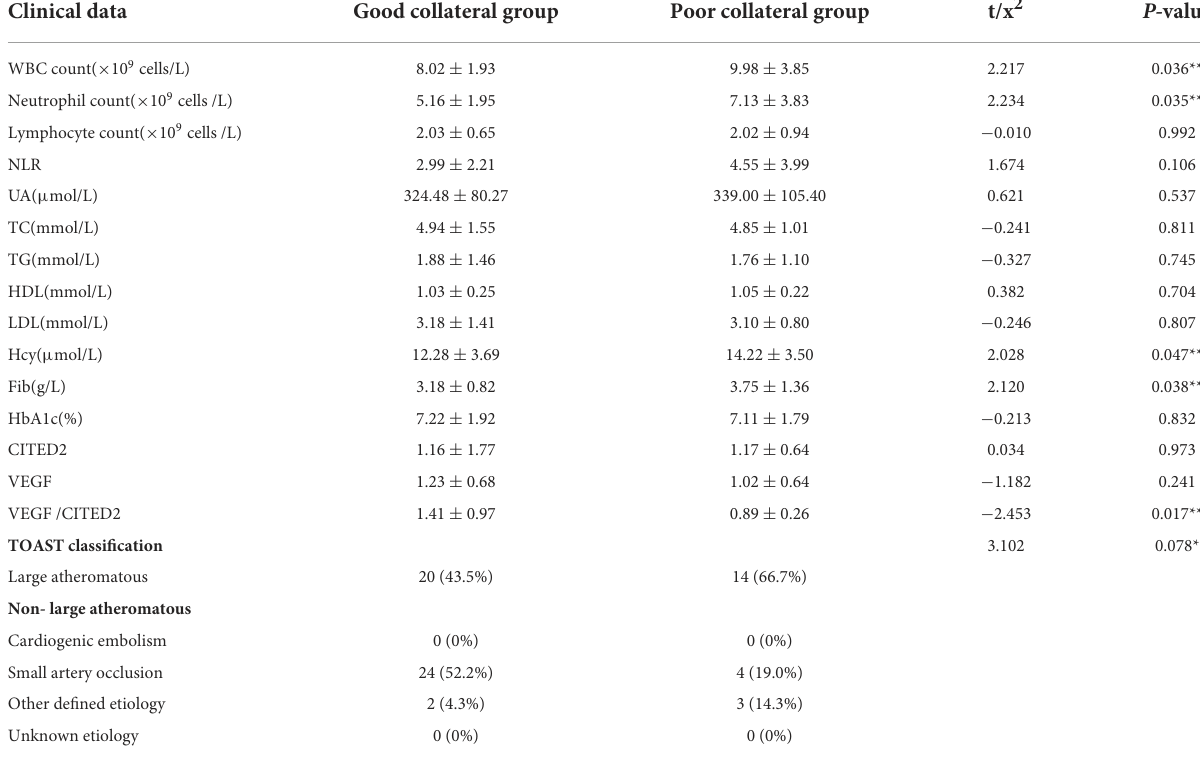
TABLE 2 Clinical data of the included patients.